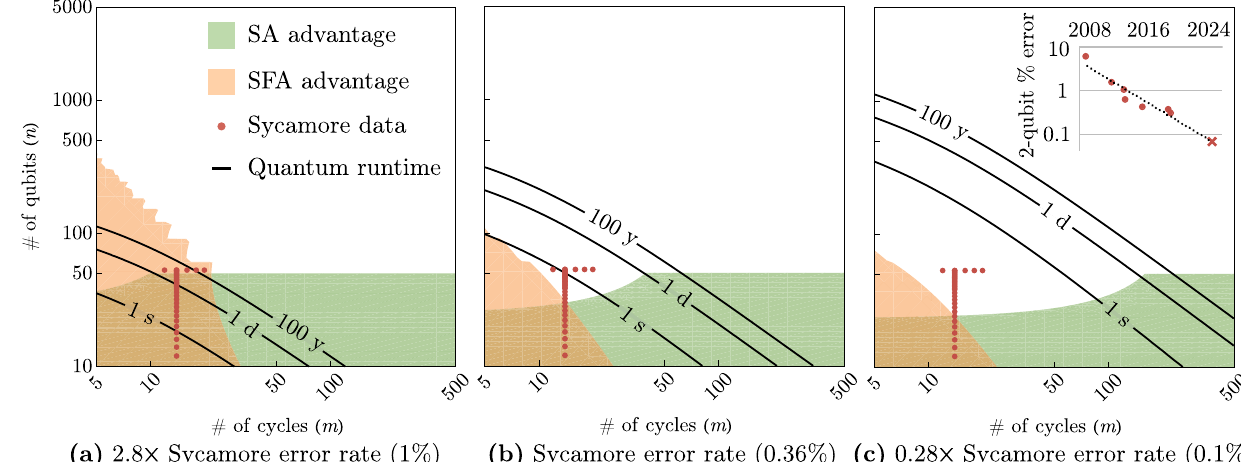
Fig. 2 Classical and quantum runtime advantage boundaries after accounting for memory constraints. Sub fi gures show different error rates relative to the Sycamore error model fi tted in Fig. 5, with corresponding captions indicating isolated two-qubit gate error rates. Black contours indicate quantum device runtimes; colored regions indicate where a classical runtime advantage is expected according to supercomputer memory and performance; red dots show the circuit width ( n ) and number of cycles ( m ) of each Sycamore experiment reported in 1 . Panel ( a ) shows that a mere 2.8 × factor increase in the error rate relative to the Sycamore chip would have required a quantum runtime of 100 years to break even with SA and SFA. Panel ( b ) shows the performance of SA and SFA relative to quantum runtimes at the error rate of the Sycamore device. Panel ( c ) uses the extrapolated fi delity of a state-of-the-art NISQ device in 2025 (inset, error rates decay by a factor of ~ 0.77 per year), and illustrates how even modest gains in error rates can signi fi cantly move the feasible quantum supremacy boundary. Extrapolated error rates are given by an exponential regression over transmon device two-qubit gate errors 1,39 – 44 . All errors of the Sycamore device (single-qubit/two-qubit gates, readout errors) are scaled proportionally to the extrapolation. Runtimes are computed using Eqs. (3), (4), and (6) with p optimized within memory limitations, using performance and memory values reported in Ref. 2